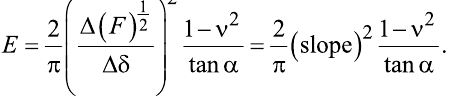
The Hertz model is used in the calculation of cell mechanical properties. The force ( F ) exerted by the probe on the cell can be expressed by the following equation,